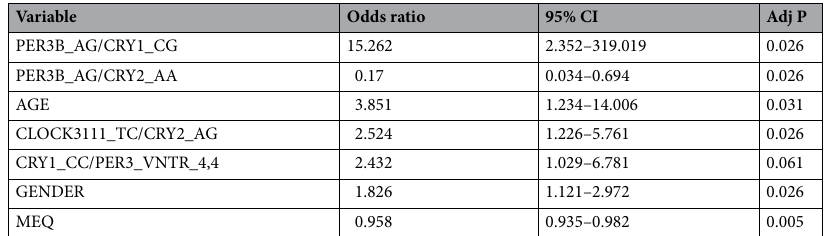
Table 1. Risk factors for anxiety symptoms. Results from a multivariate logistic regression model based on top-ranked selected features identify two-way gene combinations, most notably PER3B -AG/ CRY1 -CG, as well as demographic features that are strongly associated with anxiety symptoms. Age is coded as 1 for 18–22 years old and 0 for > 22 years old. Gender is coded as 1 for females, and 0 for males.